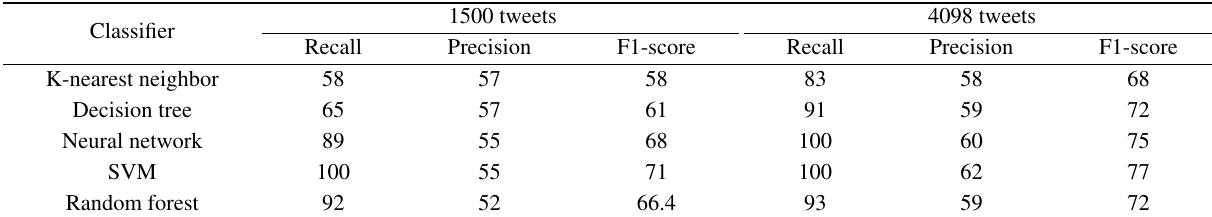
Table 10 Comparison of different classification algorithms with proposed features.